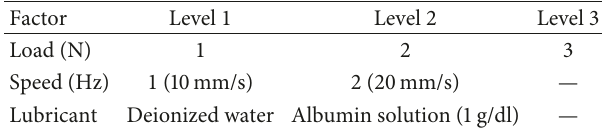
Figure 1: Schematic of friction tests. Table 1: Factors and levels for the design of experiments.